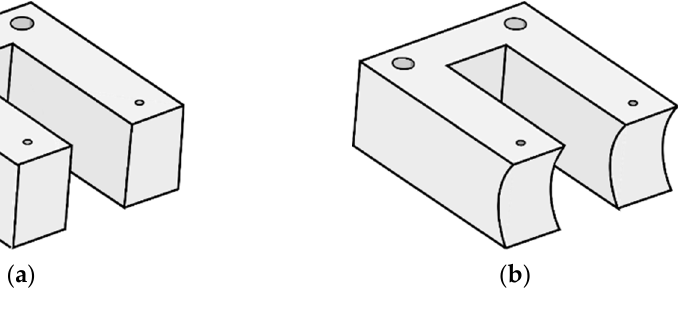
Figure 3. ( a ) Flat and ( b ) round pole surface.